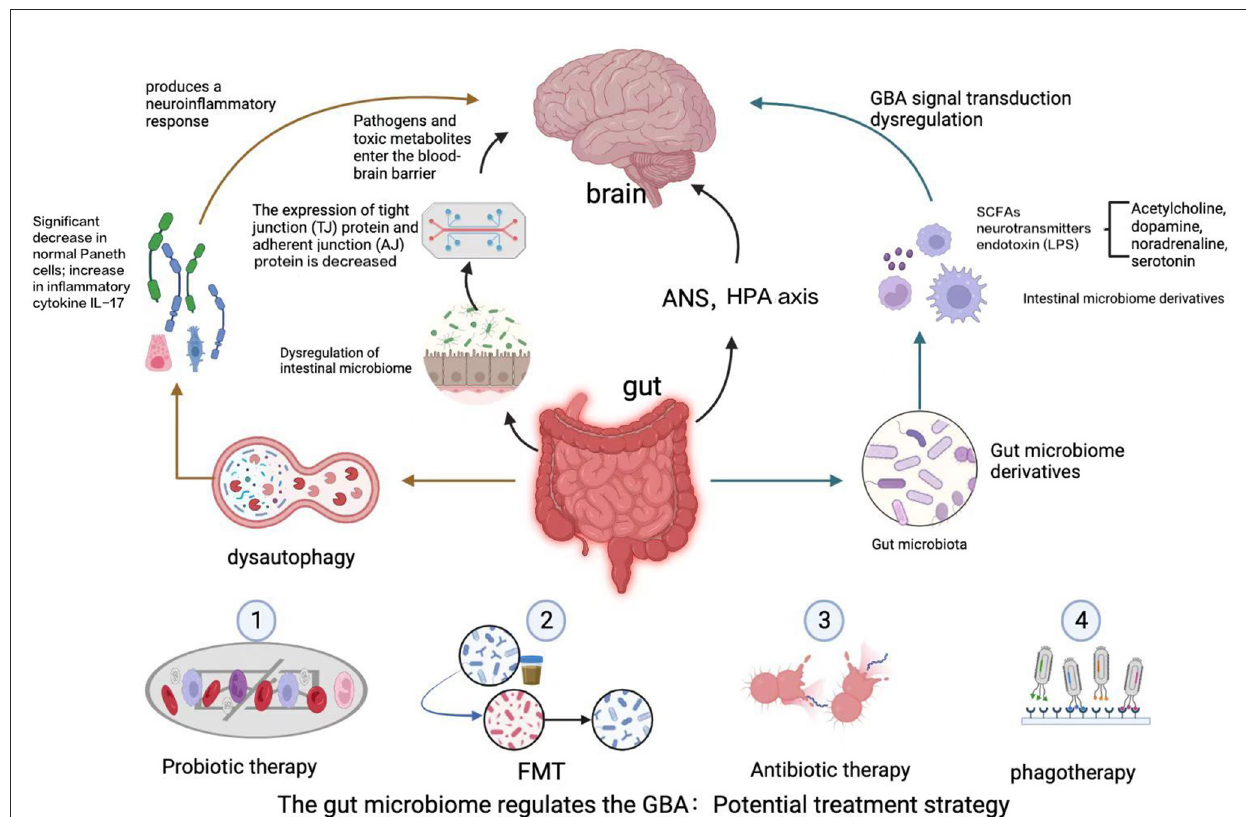
FIGURE1 The GBA is a bidirectional communication pathway between the gut and the CNS involving multiple feedback loops. Changes in the gut microbiota lead to alterations in the intestinal epithelial barrier, and the gut microbiota produces a variety of neuroactive metabolites, including SCFAs, neurotransmitters, and endotoxins. These factors affect autophagy, activate an immune response, and lead to dysregulation of the GBA via the ascending pathway from the gut to the brain, triggering neuroinflammation and neurodegenerative diseases of the central nervous system, such as ALS, AD, and PD. A potential avenue for treatment of ALS may involve manipulation of the gut microbiota and its derivatives, including via intestinal mucosal resurfacing, dietary intervention, probiotic supplementation, antibiotics, and post-antibiotic therapy, among other potential